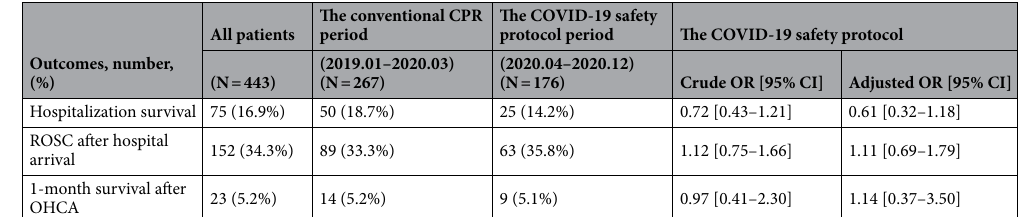
Outcomes, number,